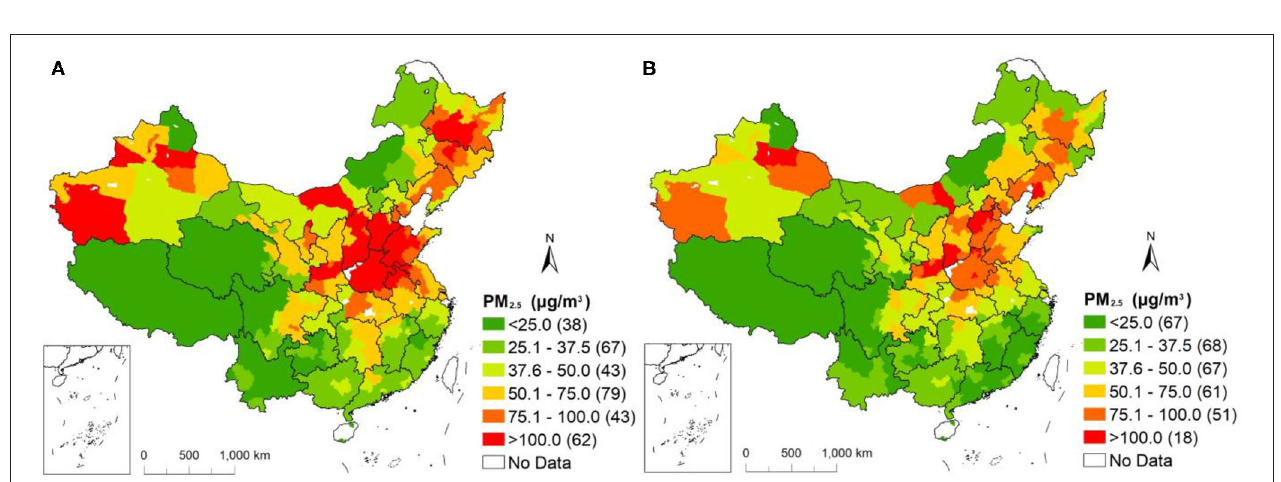
FIGURE 2 | Distributions of daily PM 2.5 concentrations in Chinese cities before (A) and after (B) lockdown measures taken in response to the outbreak of COVID-19.